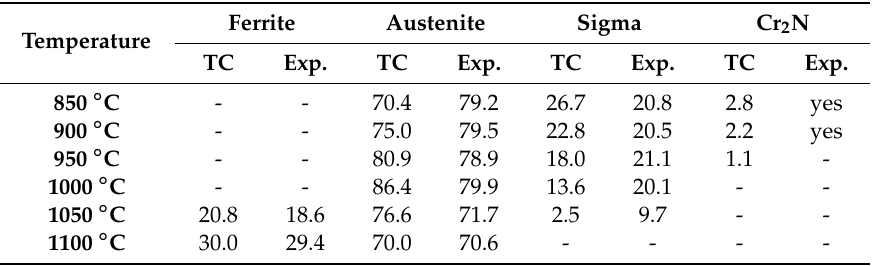
Table 4. Volume percentage of various phases after 24 h heat treatment. TC refers to Thermo-Calc calculation, while Exp. to the experimentally measured percentage (vol.%).